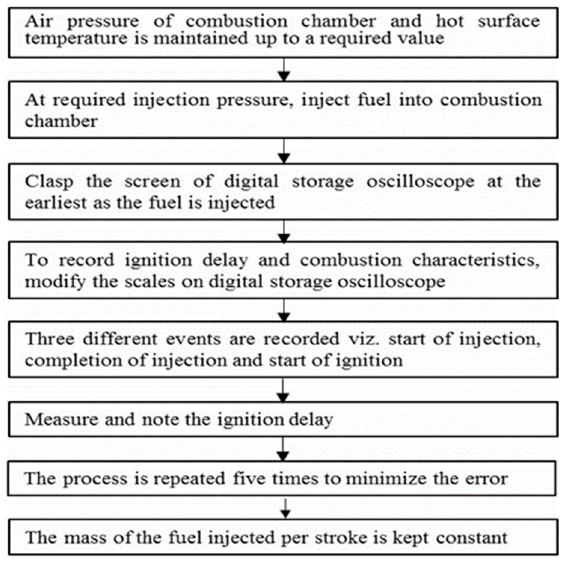
Figure 3. Flowchart displaying analysis of the work approach.